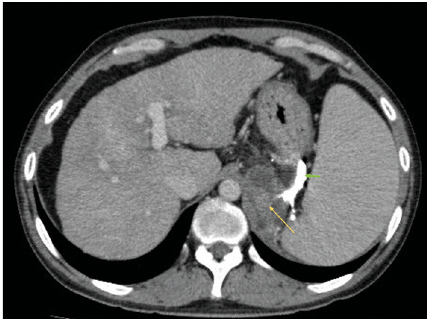
Figure 4: Computed tomography view of the abdomen (in axial view). The hypodense collection (yellow arrow) behind the stomach corresponds to the retrogastric abscess. The residual N-butyl-2- cyanoacrylate in the perigastric region is more explicit in this view (green arrow).